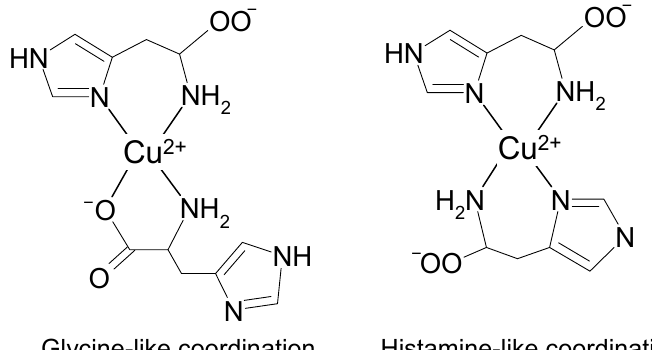
Figure 7. Glycine-like (3-NO) and histamine-like (4-N) types of coordination of two molecules of histidine to copper(II) ion in an aqueous solution at pH